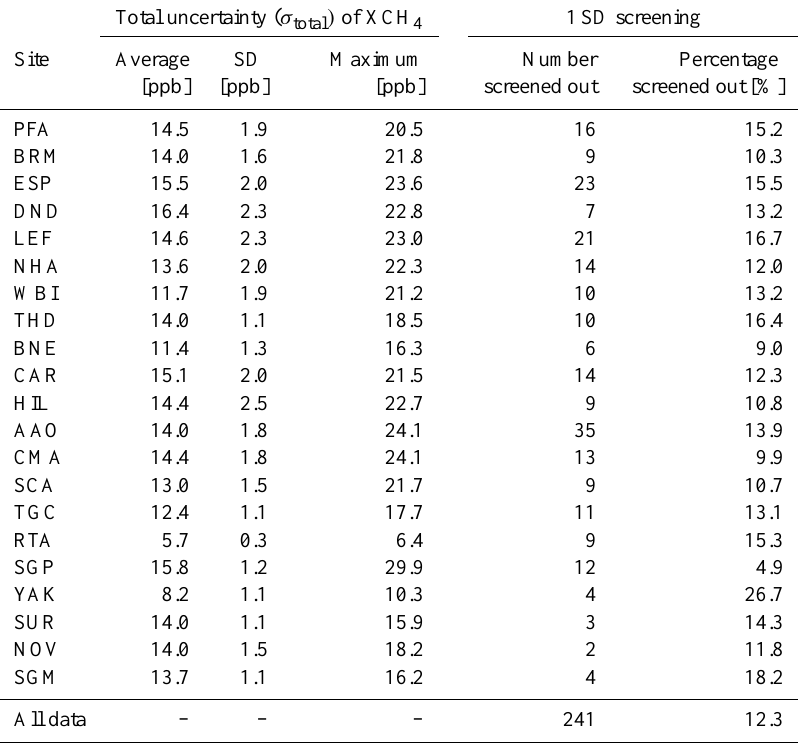
Table 3. Total uncertainty ( σ total ) of aircraft-based XCH 4 and 1 standard deviation screening (data differing from the average by more than 1 standard deviation) at each aircraft observation